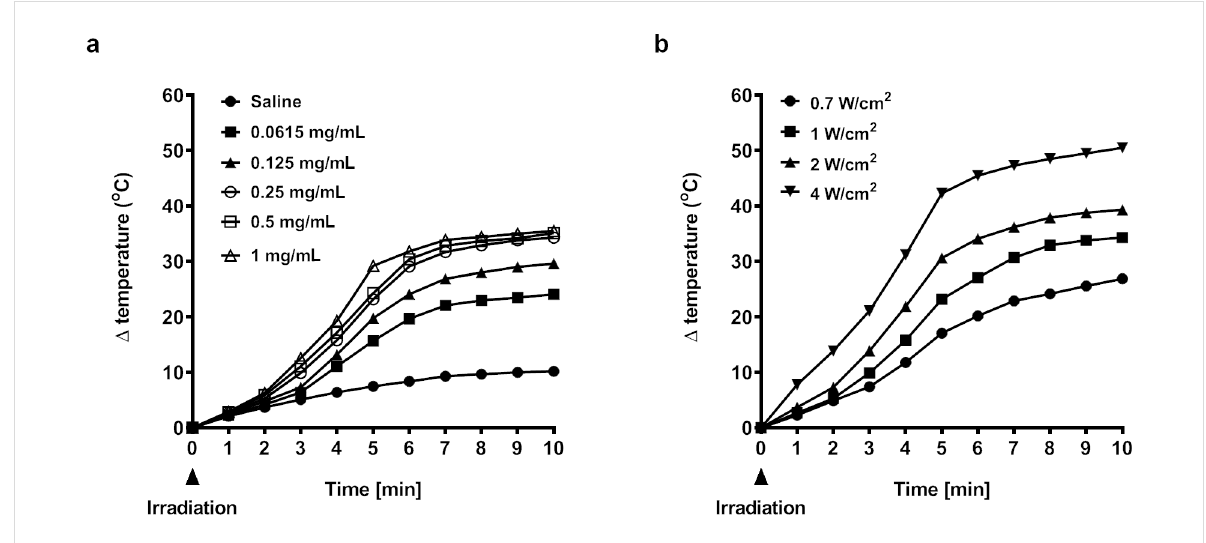
Figure 2: Photothermal conversion of Fe 3 O 4 nanoparticle clusters. (a) Temperature elevation of aqueous solutions with increasing concentrations of NPCs in response to 808 nm laser irradiation at power density of 1 W·cm − 2 . (b) Temperature elevation of solutions with 0.25 mg/mL NPCs in response to 808 nm laser irradiation at increasing power